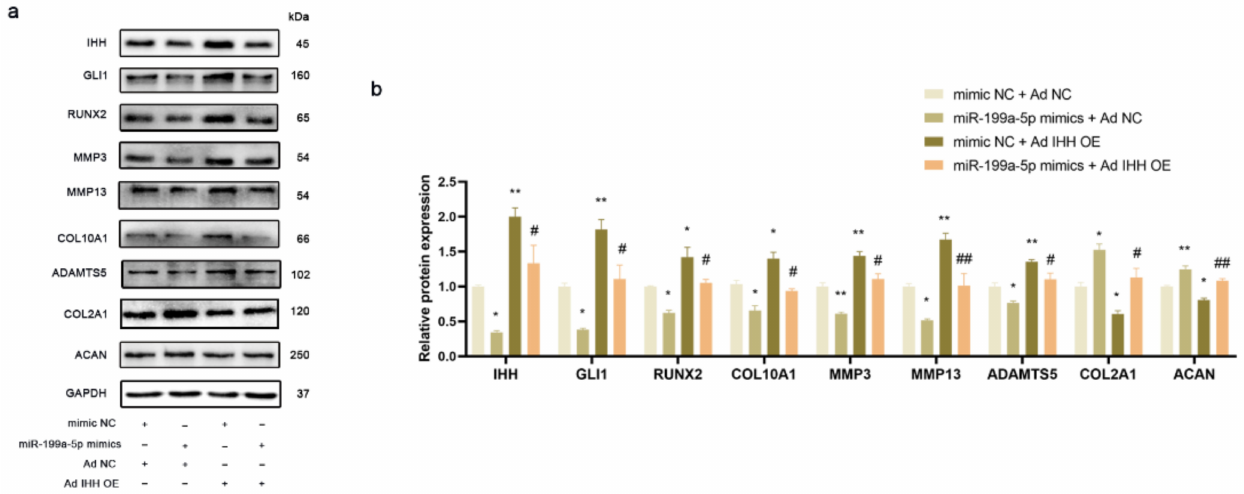
Figure 4. miR-199a-5p regulated IHH signal pathway and matrix degradation in PHCs. ( a ) Western blot analysis of IHH, GLI1, GLI2, RUNX2, COL10A1, MMP13, ADAMTS5, COL2A1, and ACAN normalized with GAPDH in the PHCs. ( b ) Statistical analysis of the western blot results from 3 independent experiments. (* p < 0.05, ** p < 0.01 versus mimic NC + ad NC group; # p < 0.05, ## p < 0.01 versus mimic NC + ad IHH OE group; n = 3 for each